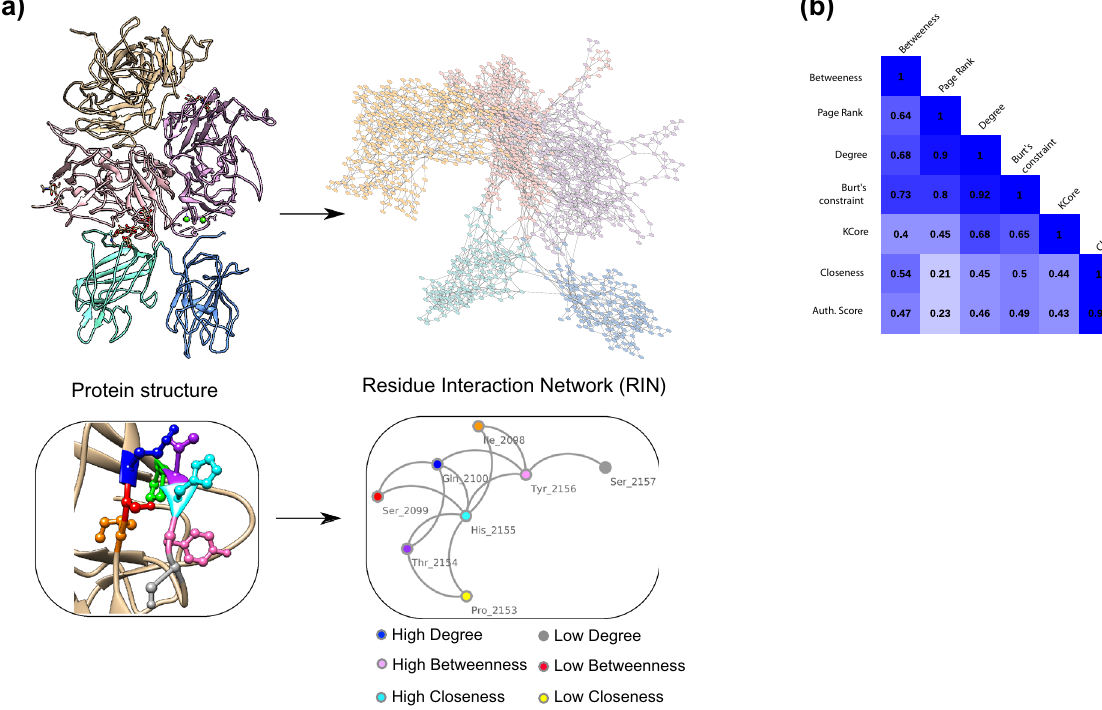
Figure 1. The FVIII Residue Interaction Network (RIN). ( a ) Each residue of the FVIII structure is represented as a node in the RIN. Two nodes are connected if either their main- or side-chains are close to each other (less than ~ 5 Å). Note that the RIN does not keep the three dimensional positional information of the domains or residues. The centrality of each node can be calculated based on the number of residues they interact (degree), whether they serve as bridges for groups of residues that would not be connected otherwise (betweenness), and are located in a position that requires few ‘steps’ to reach every other node in the network (closeness). Image created using the structure 2R7E (Ref. 3 ) and Chimera 1.14 (Ref. 62 ). ( b ) Several measures display a moderate to strong Pearson correlation to each other, despite being calculated using different underlying